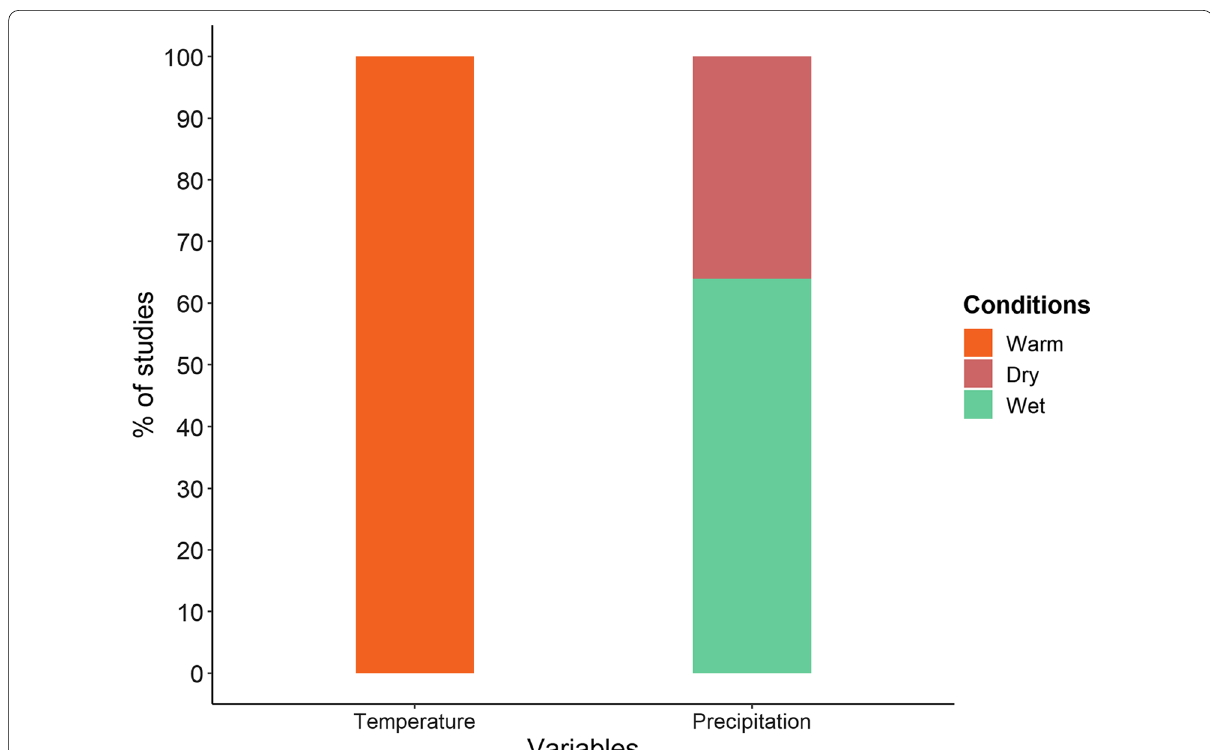
Fig. 1 Relationship of temperature and precipitation during the MMCO. The number of studies used for the warm/cold or wet/dry conditions can be found in Table